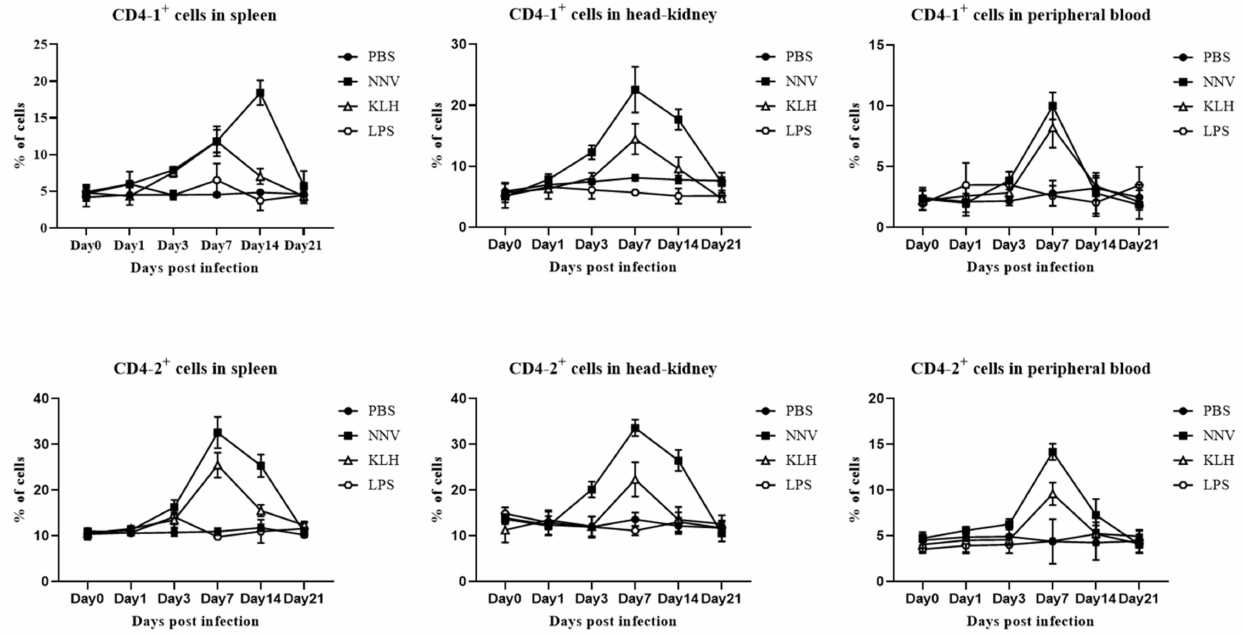
Figure 9. In vivo proliferation of helper T cells after stimulation with NNV, KLH and LPS. Leukocytes from spleen, head- kidney and peripheral blood were collected at 0, 1, 3, 7, 14 and 21 days post-administration, and stained with anti-CD4 mAbs (10F8 or 3C8), followed by FITC-conjugated goat anti-mouse IgG. Lymphocytes were gated on FSC and SSC dot plot and relative cell counts were shown compared to negative control without incubation of anti-CD4 mAbs (10F8 or 3C8). Data are represented as mean ± SD of three